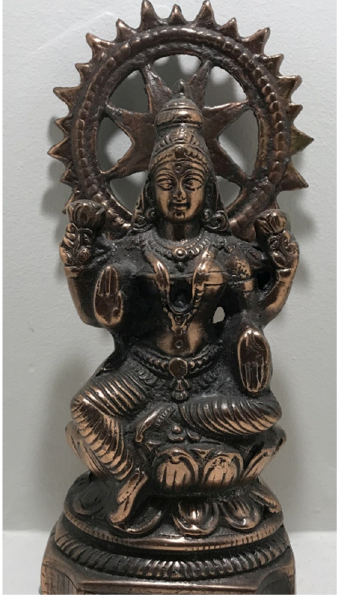
Figure 2. Here Lak ṣ m ī who is also Padma (the Lotus) is sitting on herself. She is hence governing herself, and inspecting herself (as Lotuses she holds up). She is the yogic practice of sv ā dhy ā ya : self- study, self-determination . She also embodies many other ideals of Yoga, including: svar ū pevasth ā nam /“abiding in one’s form” (YS I.3), svar ū pa-prati ṣṭ h ā /“standing on one’s form” (YS IV.34), and more literally sva-sv ā m ī /“own master” (YS II.22) (picture by author).